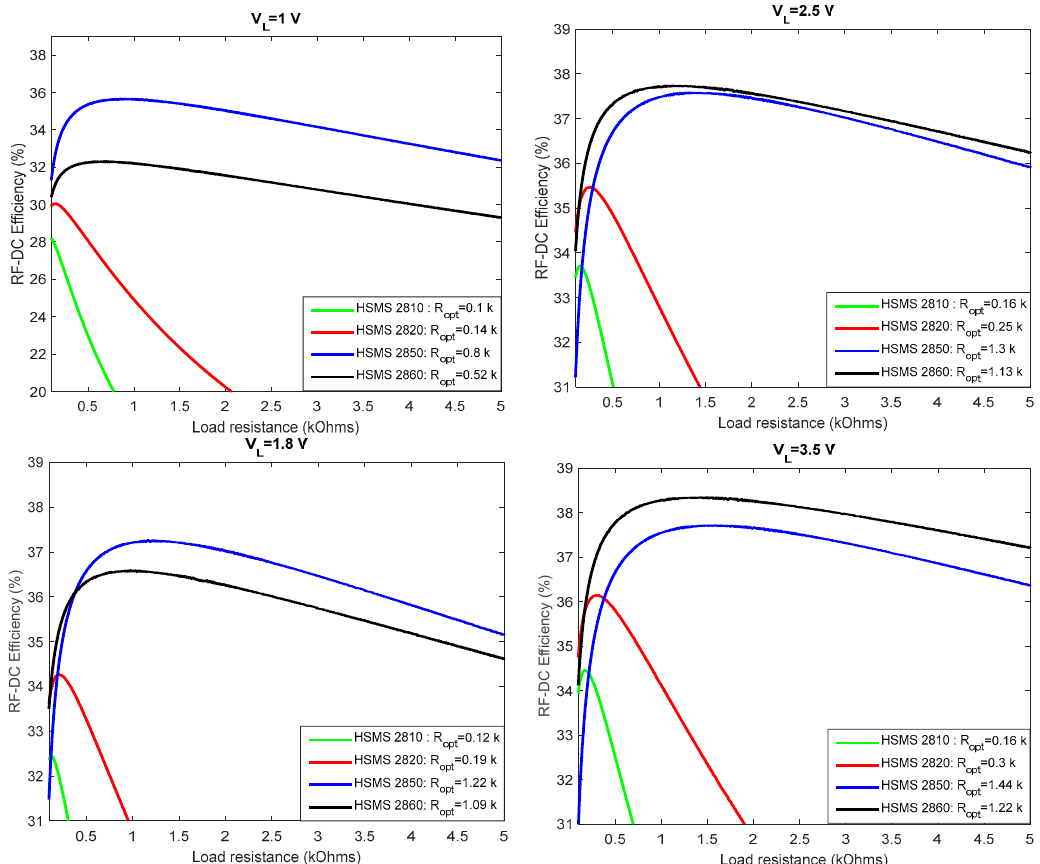
Figure 10. Efficiency as a function of load resistance for different levels of the output voltage.